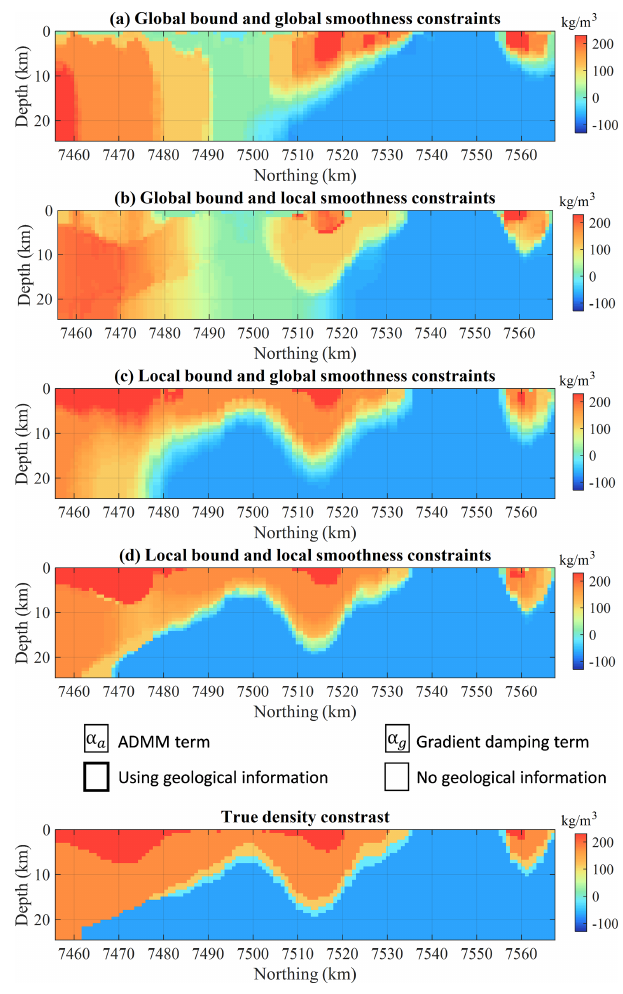
Figure 16. Results from gravity inversion using (a) global ADMM clustering and homogenous smoothness constraints, (b) global ADMM clustering and geologically derived smoothness con- straints, (c) ADMM clustering and geologically derived smoothness constraints, and (d) geologically derived ADMM clustering and ge- ologically derived smoothness constraints. For visual comparison, the true model is repeated at the